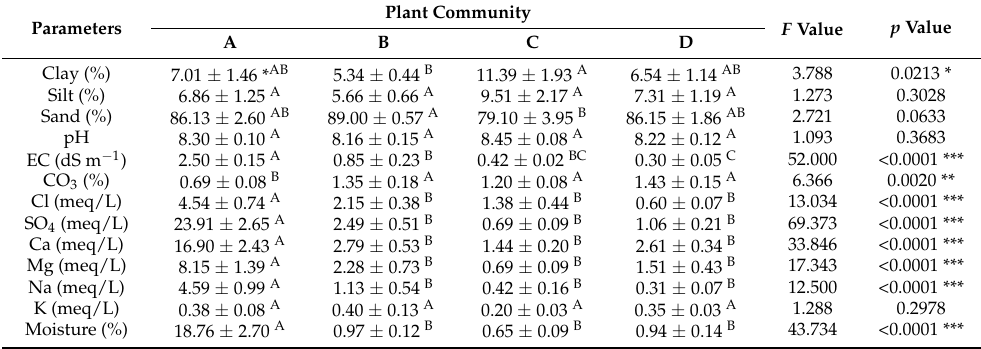
Table 2. Soil characteristics of the four determined plant communities in the study area. Plant Community Parameters